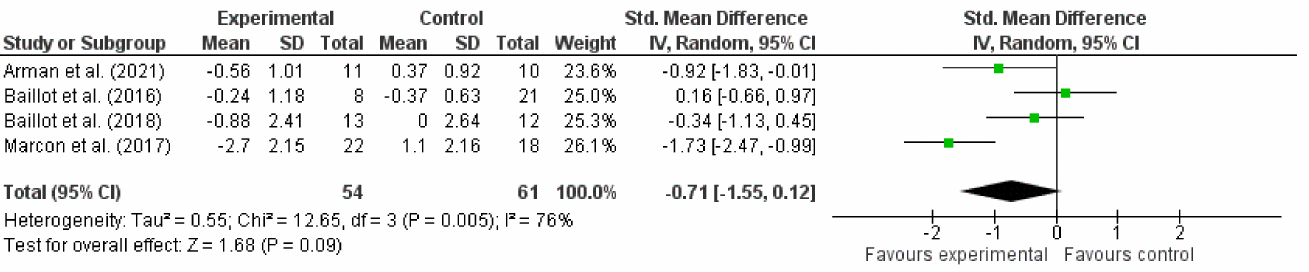
Figure 4. Forest plot of the body composition and the BMI subgroup